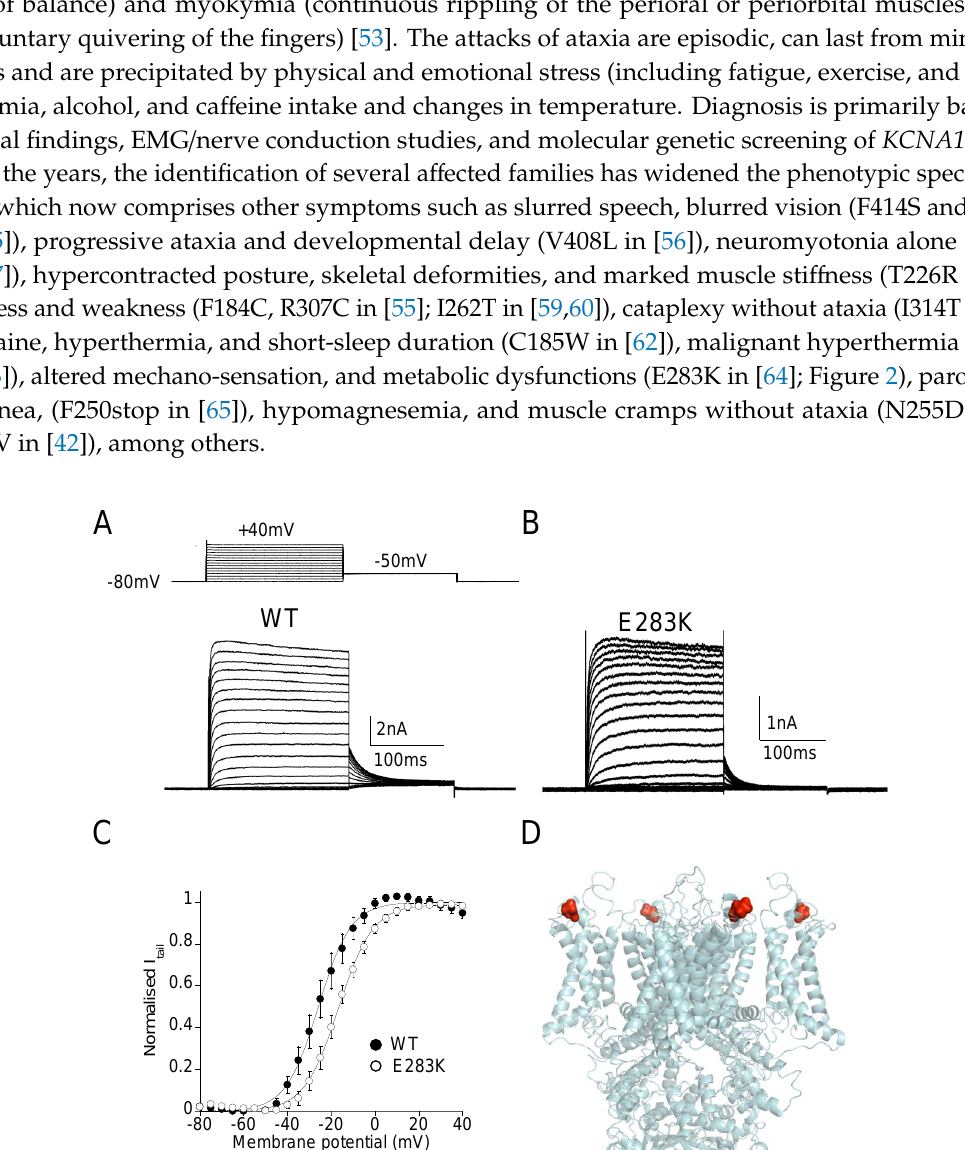
Figure 1. Cartoon showing the localization of the Kv1.1 identified mutations associated with episodic ataxia type 1 and epilepsy. Dark blue circles, mutations associated with episodic ataxia; magenta circles, mutations associated with paroxysmal kinesigenic dyskinesia; yellow circles, mutations associated with hypomagnesemia; light blue circles, mutations showing ataxia and epilepsy; red stars, mutations associated with epilepsy without ataxia.